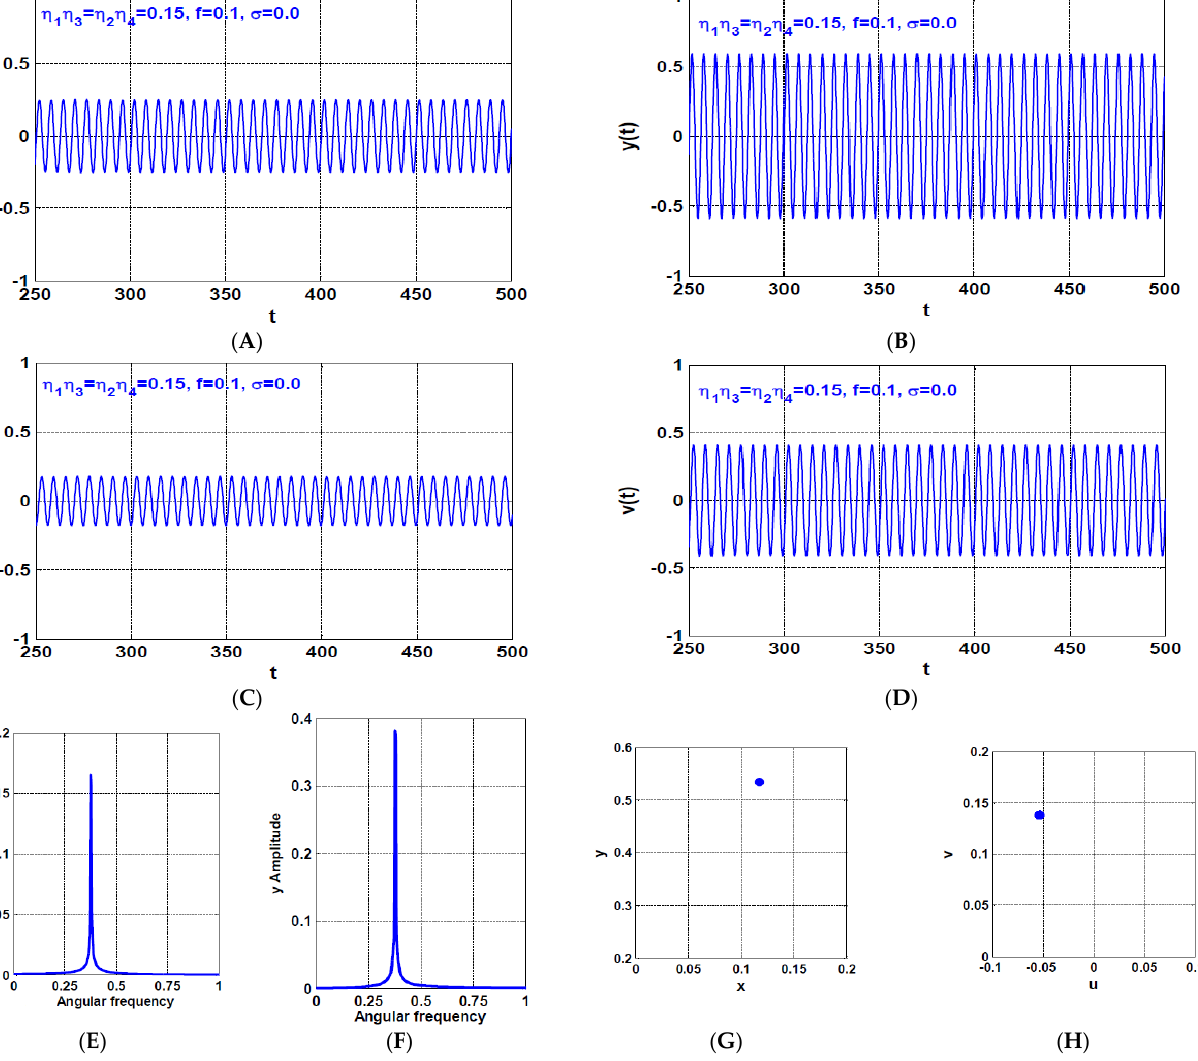
Figure 23. The rotor system steady-state time-response according to the point p (i.e., when σ = 0.0, η 1 η 3 = η 2 η 4 = 0.15): ( A , B ) temporal oscillation in X and Y directions, respec- tively, ( C , D ) temporal oscillations of the U-IRC and V-IRC, respectively, ( E , F ) frequency spectrum, ( G , H ) the corresponding Poincar é